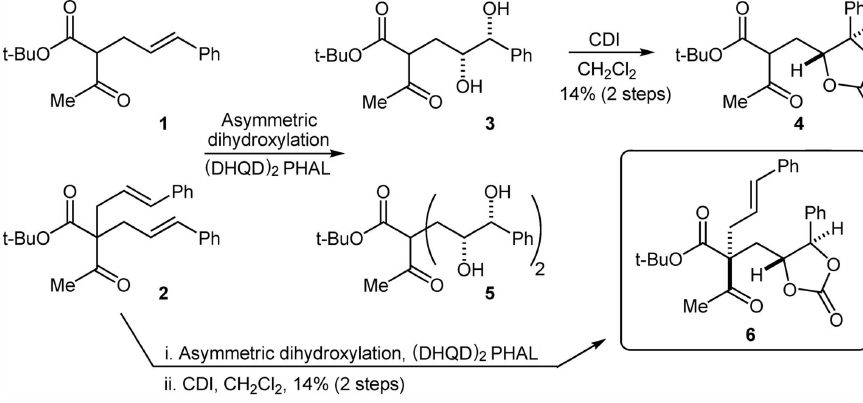
PHAL = Hydroquinidine 2